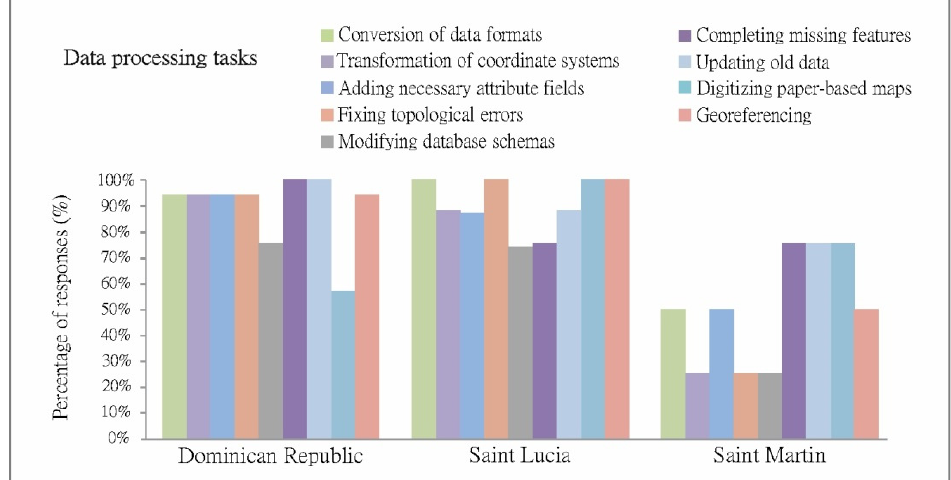
Figure 9. Data processing tasks in EMT operations (Q26).